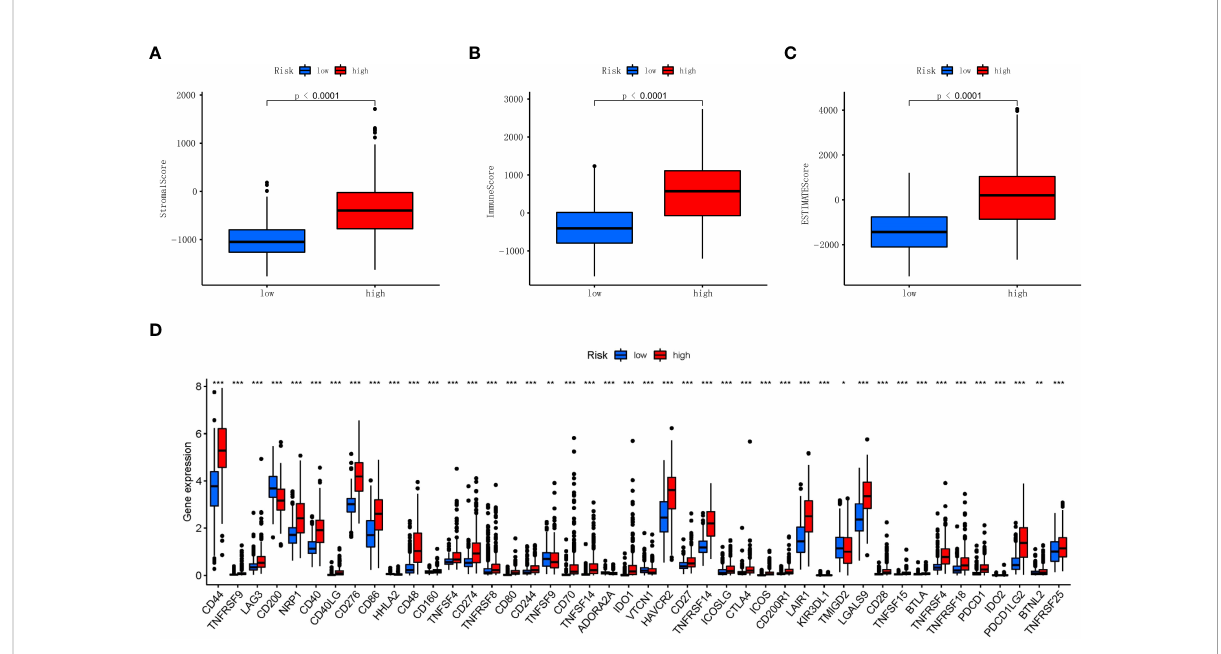
FIGURE 7 Association of stromal, immune scores, and immune checkpoint with two risk groups in TCGA. (A) Comparisons of stromal score between the two risk groups in TCGA. (B) Comparisons of immune scores between the two risk groups in TCGA. (C) Comparisons of ESTIMATE score between the two risk groups in TCGA. (D) Boxplot of the expression levels of immune checkpoint between the two risk groups in TCGA. *p < 0.05, **p < 0.01, ***p < 0.001. TCGA, The Cancer Genome